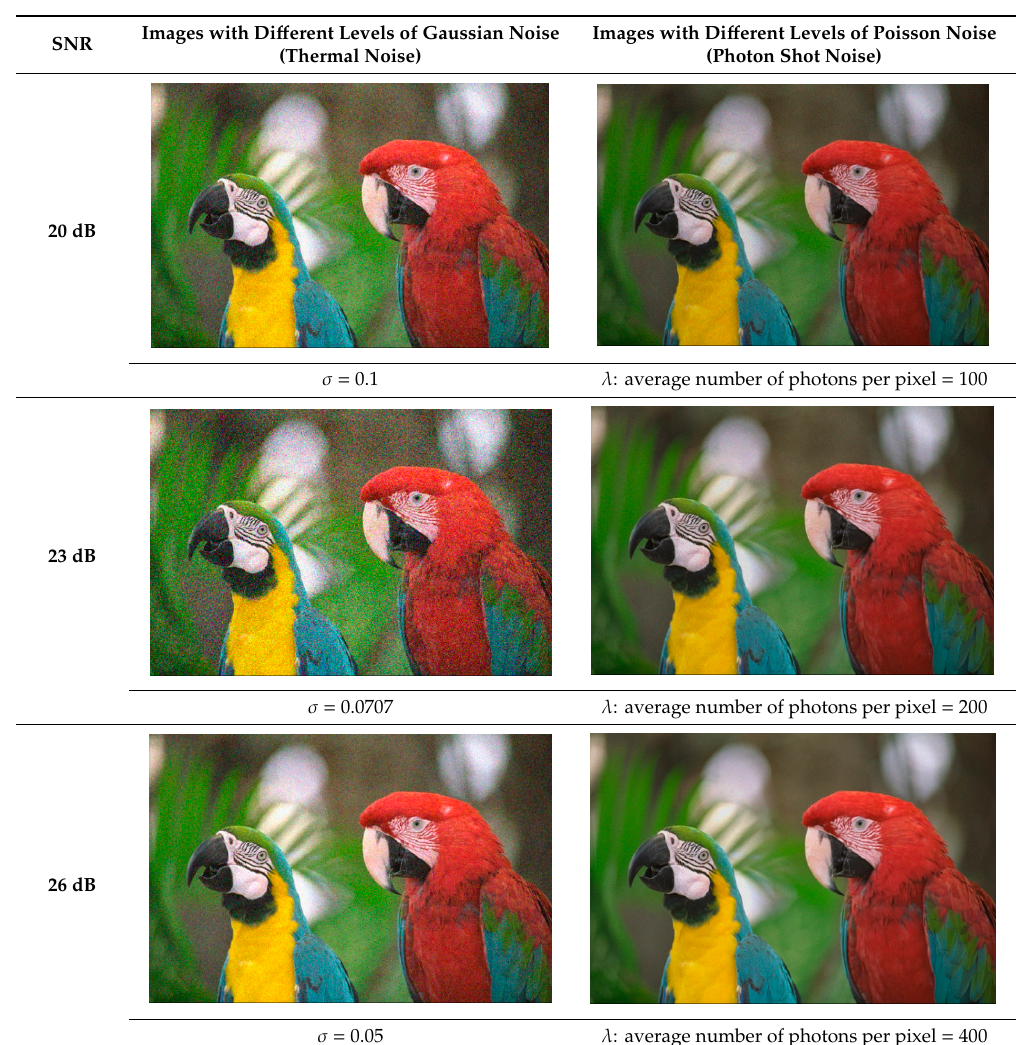
Table A1. Comparison of Gaussian and Poisson noisy images.